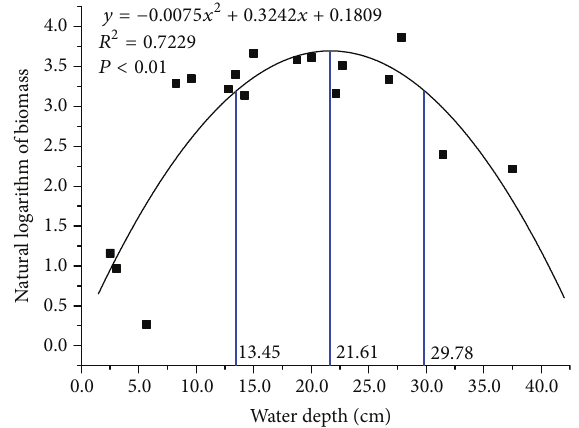
Figure 3: The secondary nonlinear regression based on Gaussian Model of Carex lasiocarpa population biomass and water depth.